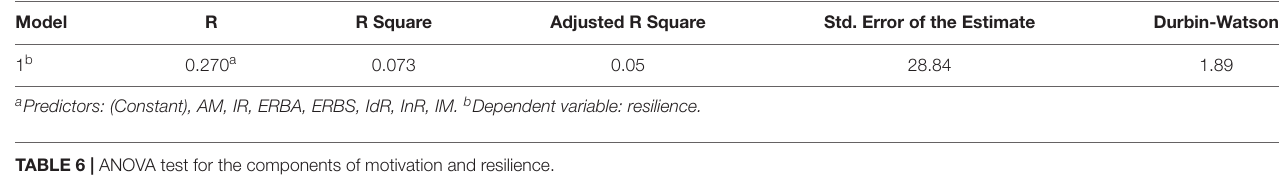
TABLE 5 | Model summary for the components of motivation and resilience.